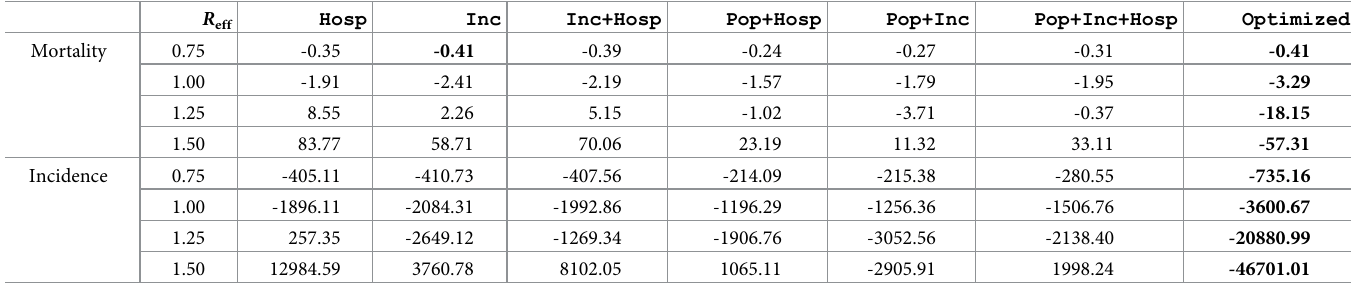
Table 5. Absolute difference in mortality (expected number of deaths) and cumulative incidence (expected number of cases) during a 250-day time horizon resulting from different vaccination strategies with respect to baseline strategy ( Pop ) for τ = 0.5. Highest reductions are indicated in boldface. Results for different values of τ are shown in S1 File, including